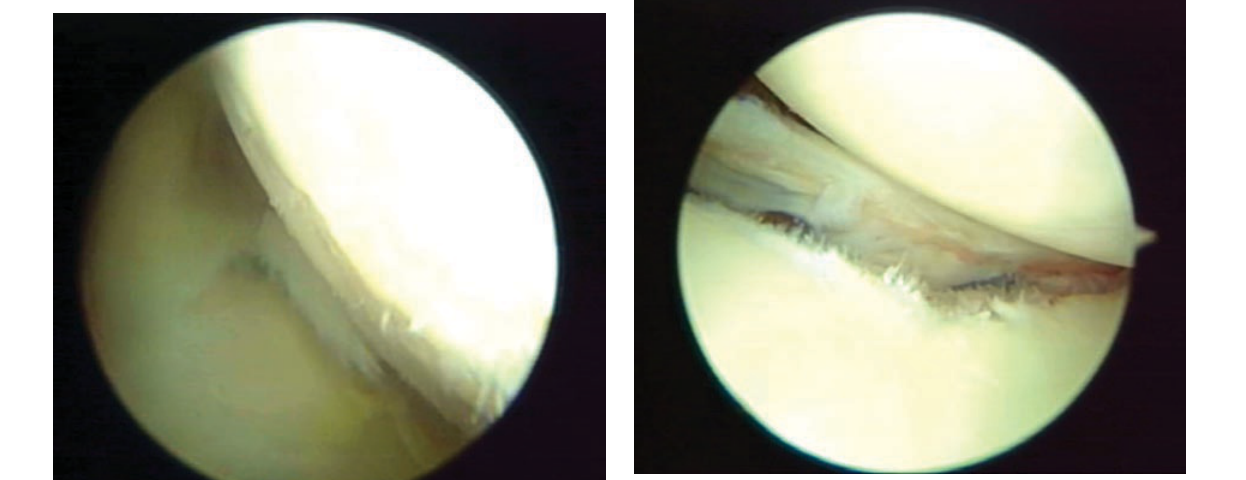
Figure 1. Arthroscopic view of chondral lesion in anterosuperior portion of the humeral head.